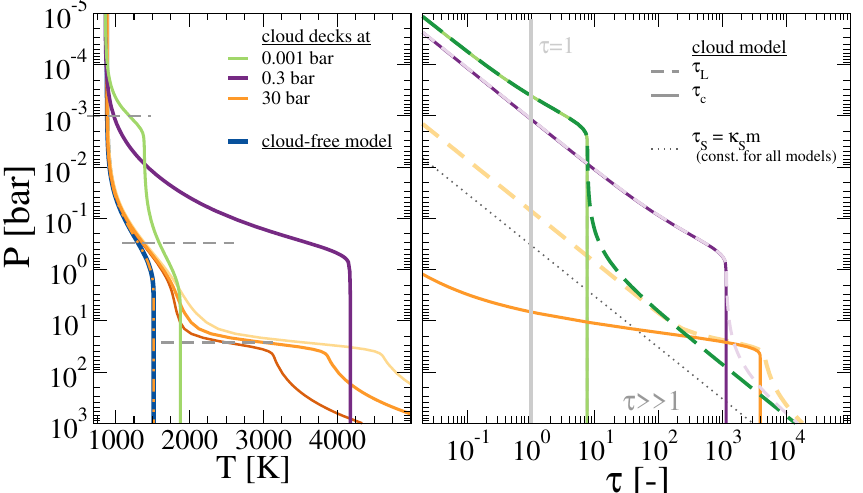
Figure 4. Similar to Figure 3 but for WASP-39b and three possible cloud locations at 0.001 (green), 0.3 (purple) and 30 bar (orange) as well as the cloud-free atmosphere (blue, only left panel). For the cloud deck at 30 bar, we show the resulting P – T profiles for T int = 300,400,500 K (from darker to lighter orange) as well as the isotherm (dash-dotted,